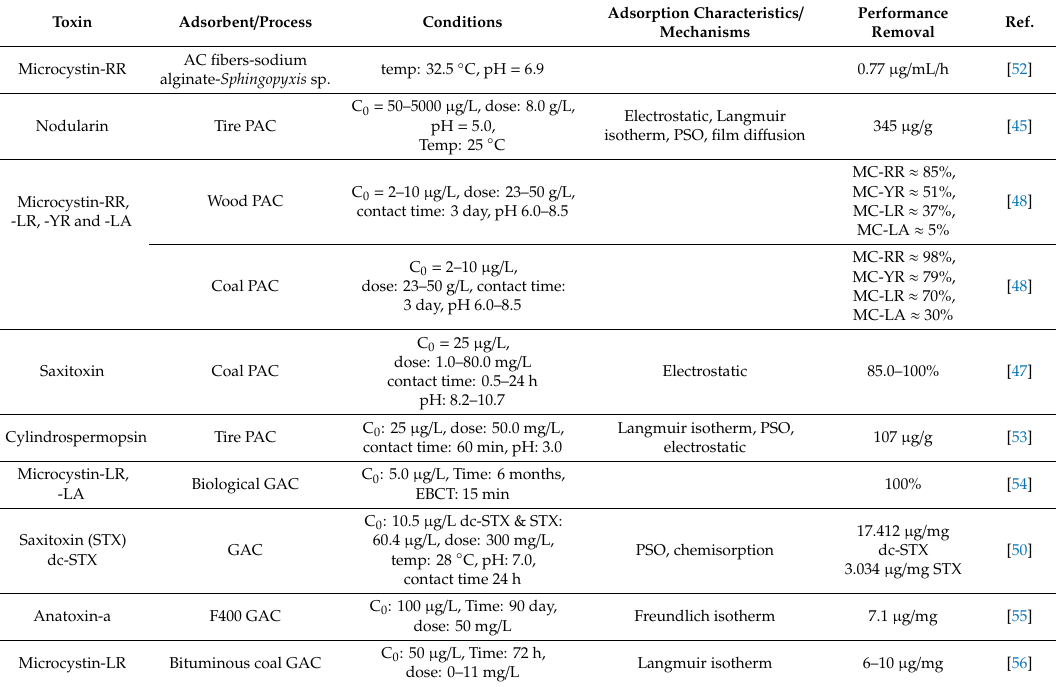
Table 2. Performance of di ff erent coal-based adsorbents during the treatment of cyanotoxins. Toxin Adsorbent / Process Conditions Adsorption Characteristics